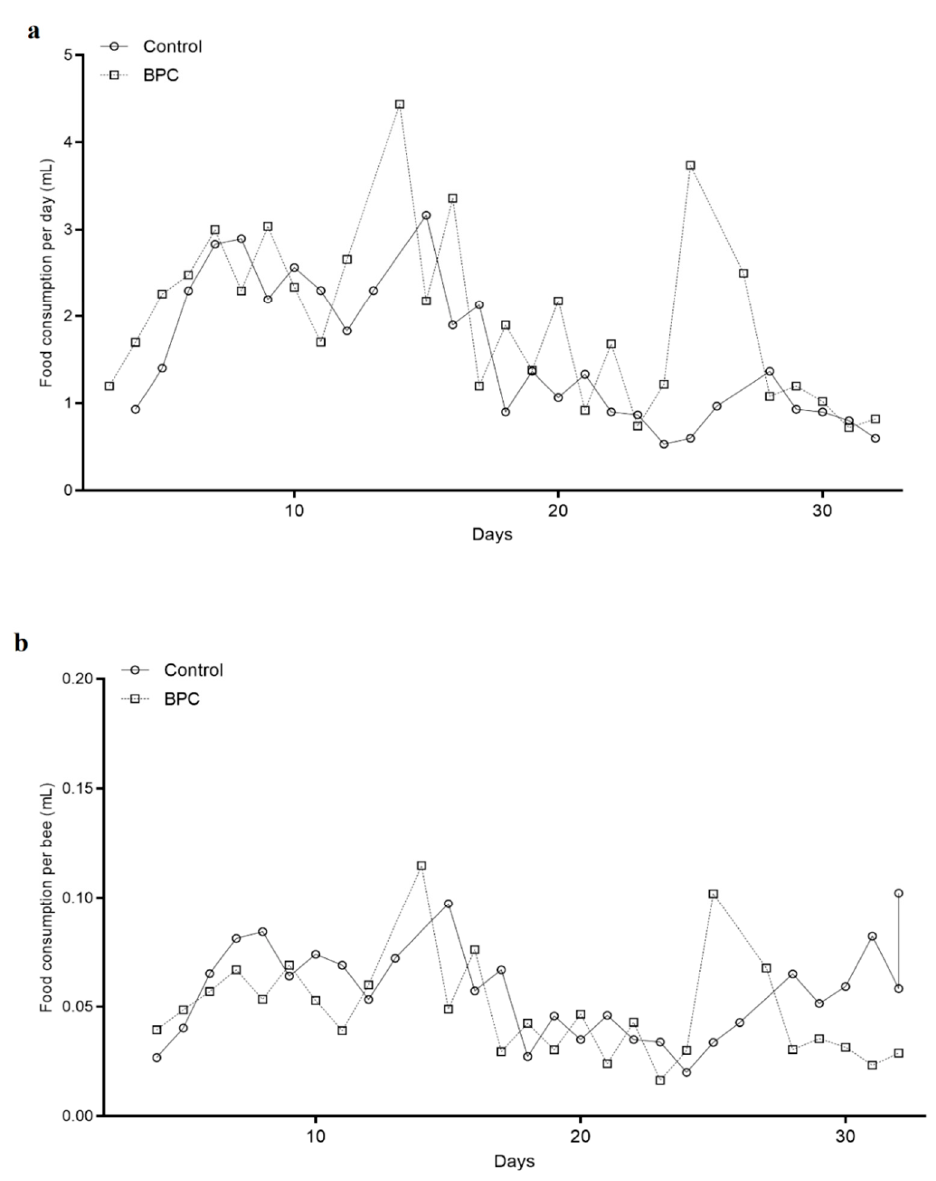
Figure 2. Food consumption amounts during experiments in laboratory-controlled conditions, for the BPC and control group ( a )–cumulative amounts of diet consumption per day, ( b )–amounts of diet consumption per bee). No statistically significant differences.